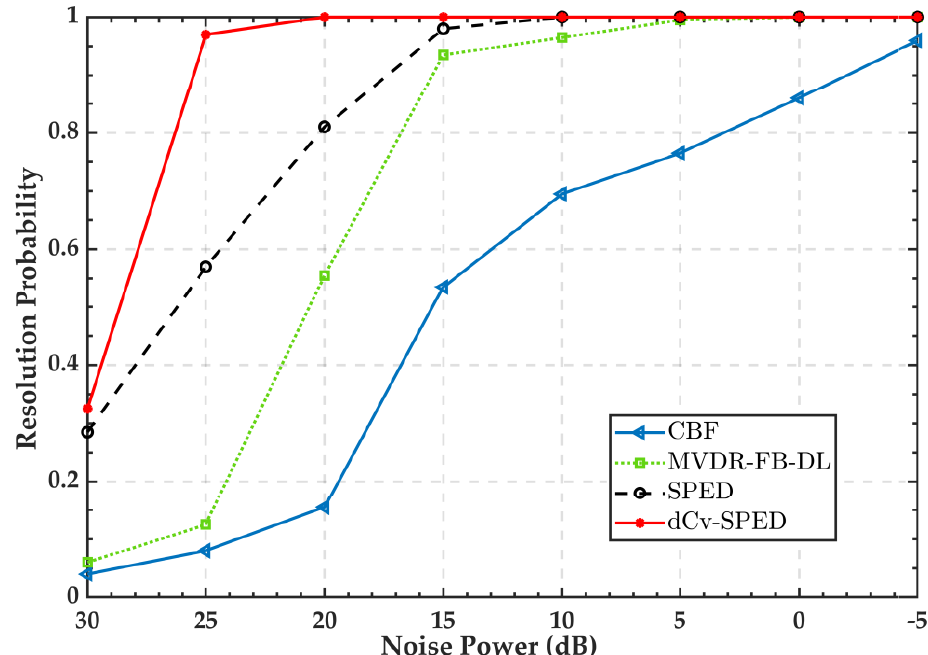
Figure 9. Resolution probability vs. noise power for the CBF, SPED, MVDR-FB-FL, and dCv-SPED under array perturbations.